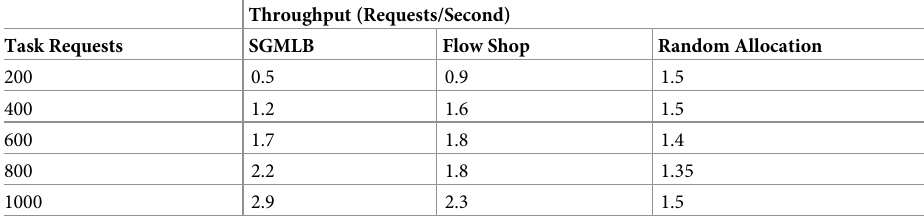
Table 3. Throughput value for task requests per second.